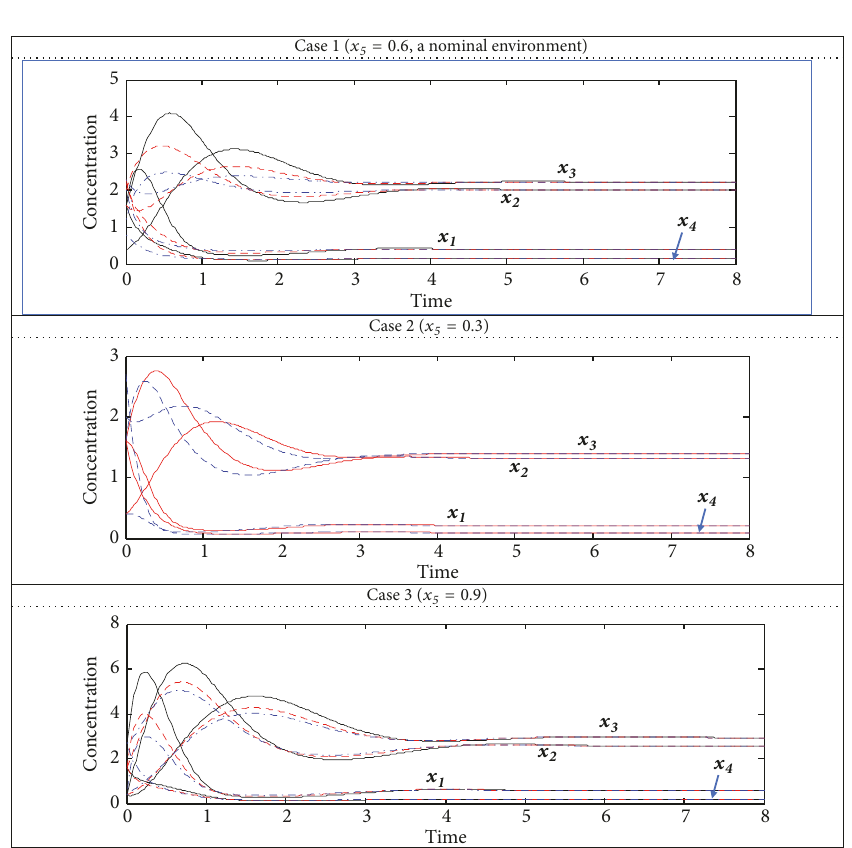
Figure 10: Simulation results for a branch pathway system under different experiment environments (independent variables 𝑥 5 = 0.6, 0.3 and 0.9) with various initial conditions: the initial conditions are set at [1.6 1.6 0.4 1.6] (black solid lines), [2.2 2 1.6 2.3] (red dashed lines), and [2 1.2 2.3 0.8] (blue dashed lines) for the case x5 = 0.6, at [1.6 1.6 0.4 1.6] (red solid lines) and [2.7 1.6 2 0.4] (blue dashed lines) for the case x5 = 0.3, and at [2.7 0.4 0.4 1.6] (black solid lines), [1.6 1.6 0.4 1.6] (red dashed lines), and [0.4 2.7 0.4 2.7] (blue dashed lines) for the case x5 =